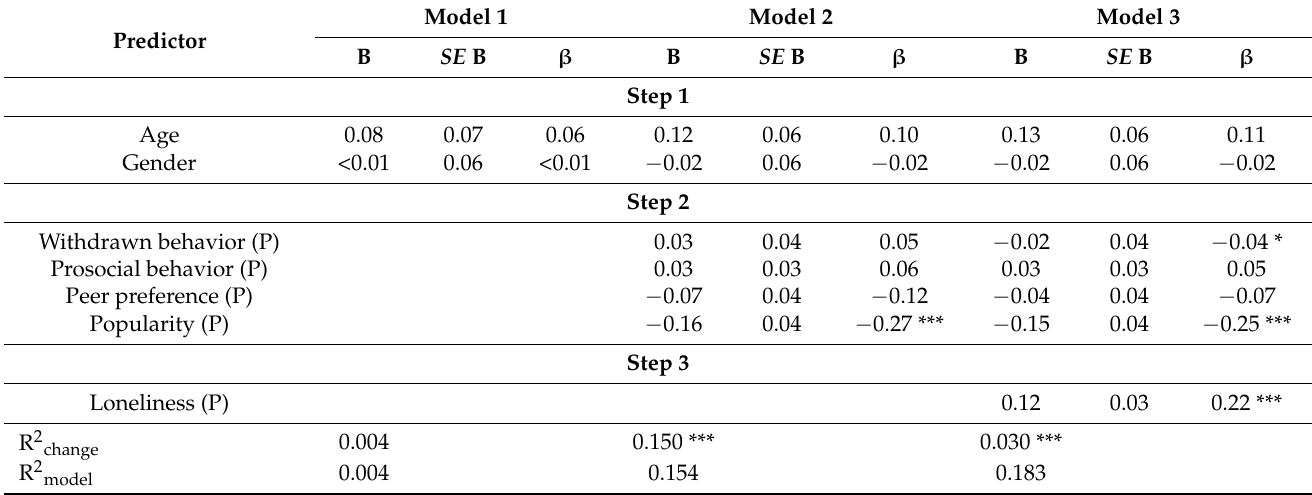
Table 5. Hierarchical Regression Model of Social Characteristics and Loneliness Peer Nominations Predicting Self-Reported Loneliness.